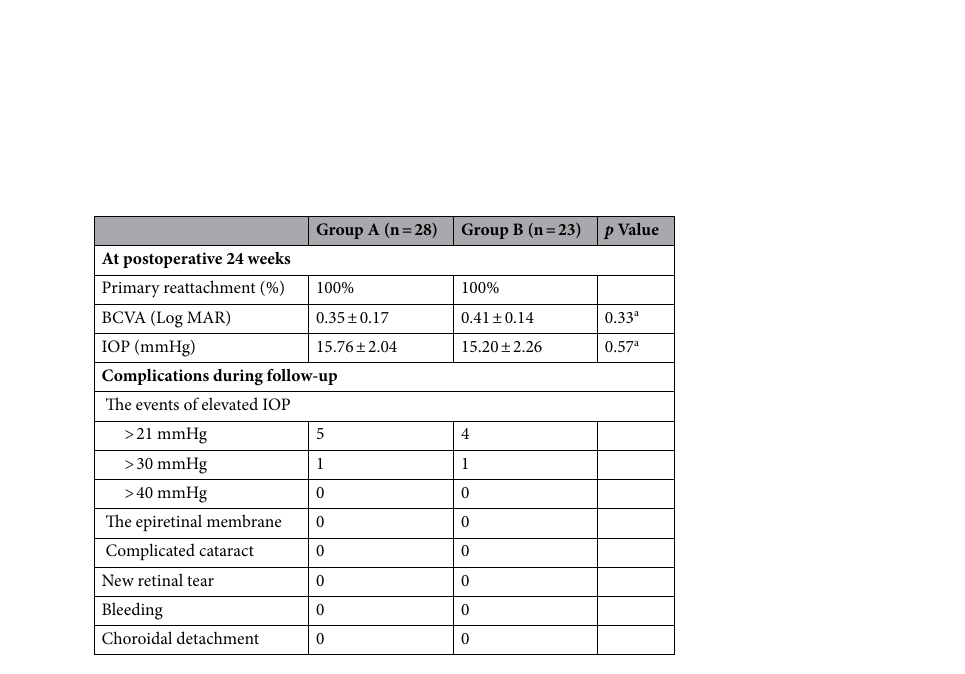
Table 4. Postoperative clinical characteristics and complications. a t -test. BCVA, Best Corrected Visual Acuity; IOP, Intraocular